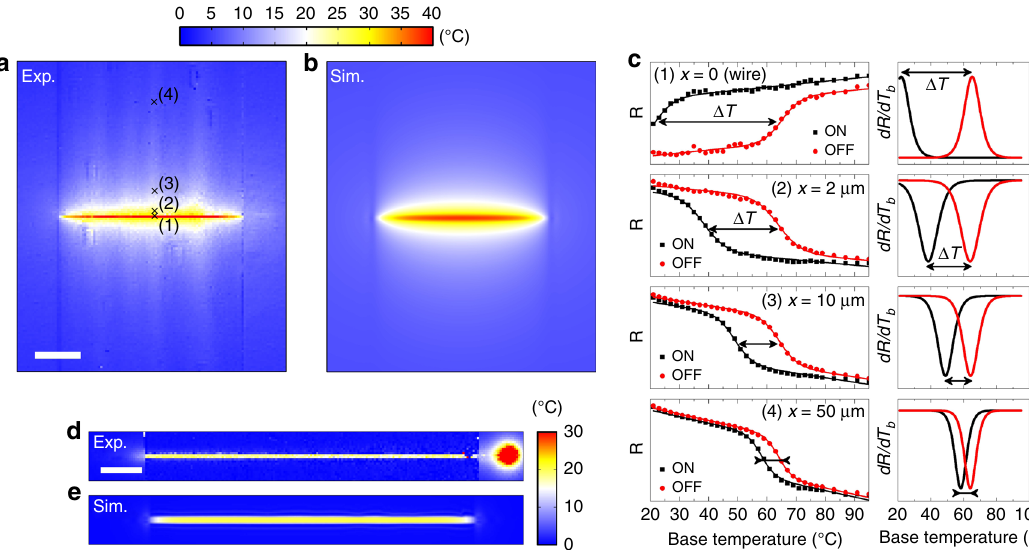
Fig. 4 Thermal mapping of a Joule-heated gold nanowire on glass and silicon substrates. a Experimental and b simulated temperature maps ( Δ T ) of the nanowire (80 µ m× 1 µ m ×50nm) on glass, heated by the application of an electrical current of 4mA. The pixel size of the experimental map is 1×1 µ m 2 . Scale bar, 20 µ m. c Typical ON-state ( I = 4mA) and OFF-state ( I = 0) re fl ectivity curves measured in selected pixels, marked by crosses in a , at different distances ( x = 0, 2, 10, and 50 µ m) from the wire. Note that the re fl ectivity signal increases with T b on the gold wire, but it goes down on glass. Solid lines are the results of a curve- fi tting procedure using a sigmoidal function. The temperature shift between the two peaks in the corresponding derivative curves (d R /d T b vs. T b ) directly gives the average temperature rise in each pixel. d Experimental and e simulated temperature maps ( Δ T ) of an identical nanowire on top of a silicon substrate, Joule-heated by the application of an electrical current of 7mA. The pixel size of the experimental map is 0.5× 0.5 µ m 2 . Scale bar, 10 µ